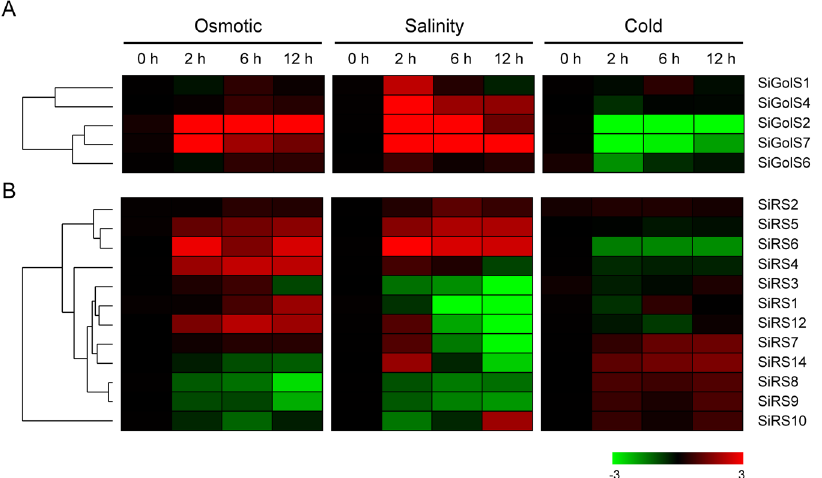
Figure 6. Expression profiles of SiGolS and SiRS genes under various abiotic stress treatments. Two-week-old seedlings were subjected to osmotic (15% PEG 6000), salt (150 mM NaCl), and cold (4 °C) stresses. The log2- transformed values (mean of three replicates) of the relative expression levels of the SiGolS ( A ) and SiRS ( B ) genes under abiotic stresses based on qPCR were used for creating the heatmap using Cluster 3.0. Changes in gene expression are shown in color as the scale. Original data was shown in Supplementary Figs S8 and S9.